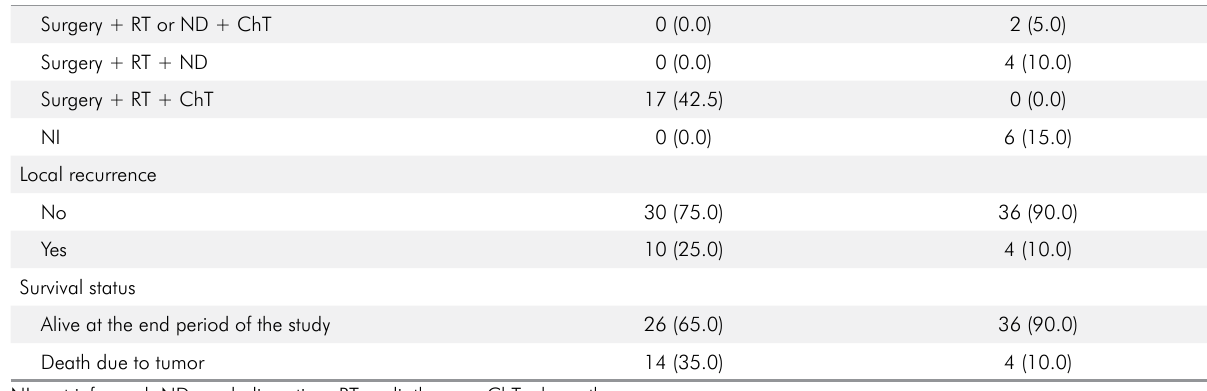
of XRCC1 and XPF in these tumors (Table 4).